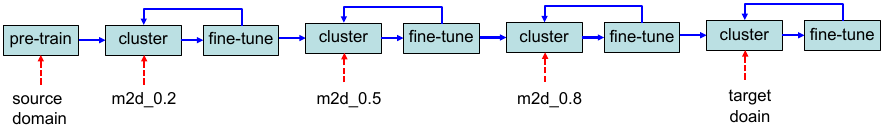
Figure 4. The training pipeline of our method. m2d_0.2 denotes the features of images generated by GAN, which transfers the style from Market1501 to DukeMTMC-reID for λ =